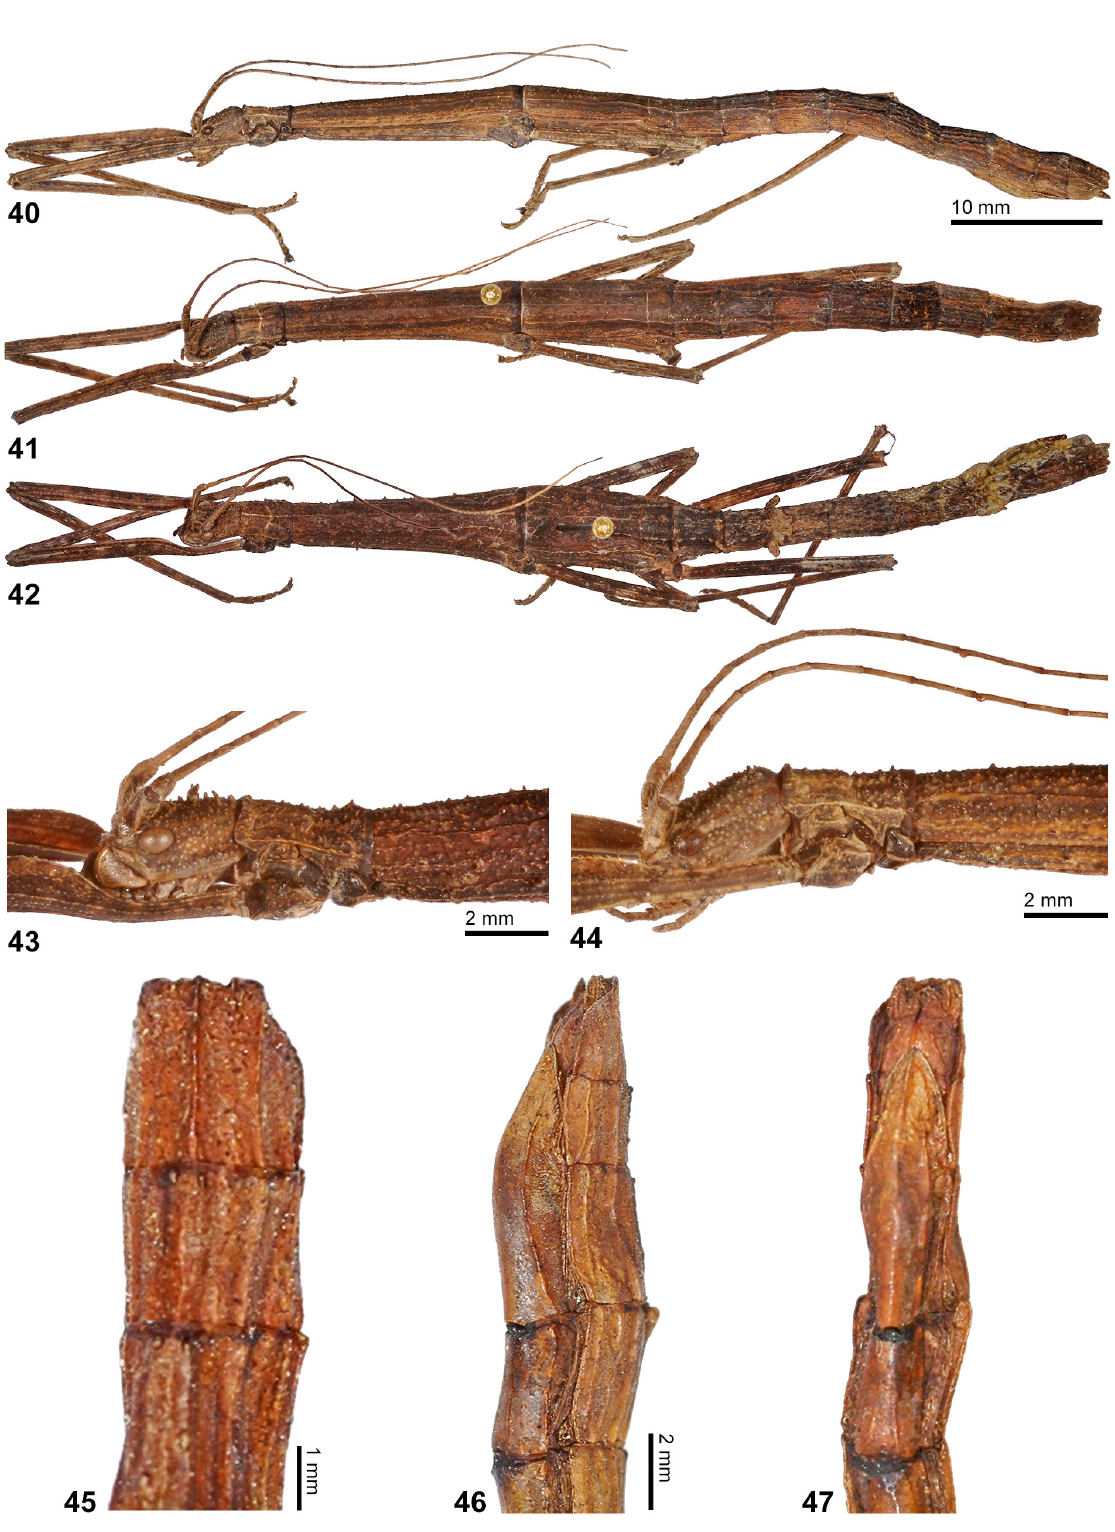
Figs 40–47. Lobolibethra tricarinata sp. nov. 40 . ♀, HT: lateral view (ANSP). 41 . ♀, HT: dorsal view (ANSP). 42 . ♀, PT: dorsal view (ANSP). 43 . ♀, PT: head and pronotum (ANSP). 44 . ♀, HT: head and pronotum (ANSP). 45 . ♀, PT: apex of abdomen in dorsal view (MNCN). 46 . ♀, PT: apex of abdomen in lateral view (MNCN). 47 . ♀, PT: apex of abdomen in ventral view